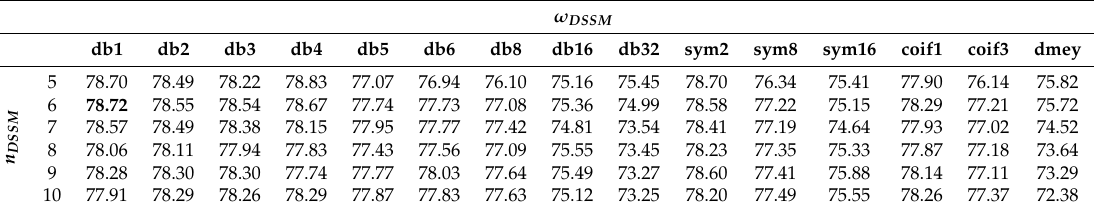
Table 14. The accuracy (%) of five class sleep stage classification with different wavelet bases and different order of DSSM under AASM standard. Only DSSMFs are used, no LEFs.